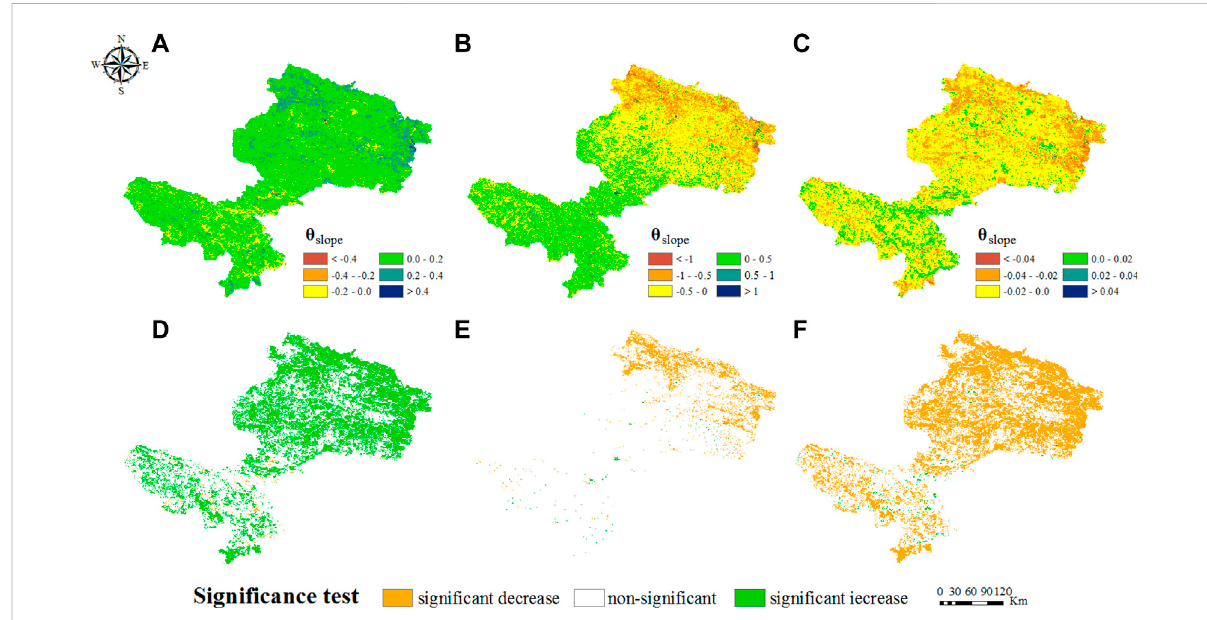
FIGURE 7 Spatialpatternofthe θ slope andsigni fi cance( p < 0.05 ): (A) θ slope ofSWC, (B) θ slope ofEC, (C) θ slope ofpH, (D) signi fi cant θ slope ofSWC, (E) signi fi cant θ slope of EC, and (F) signi fi cant θ slope of